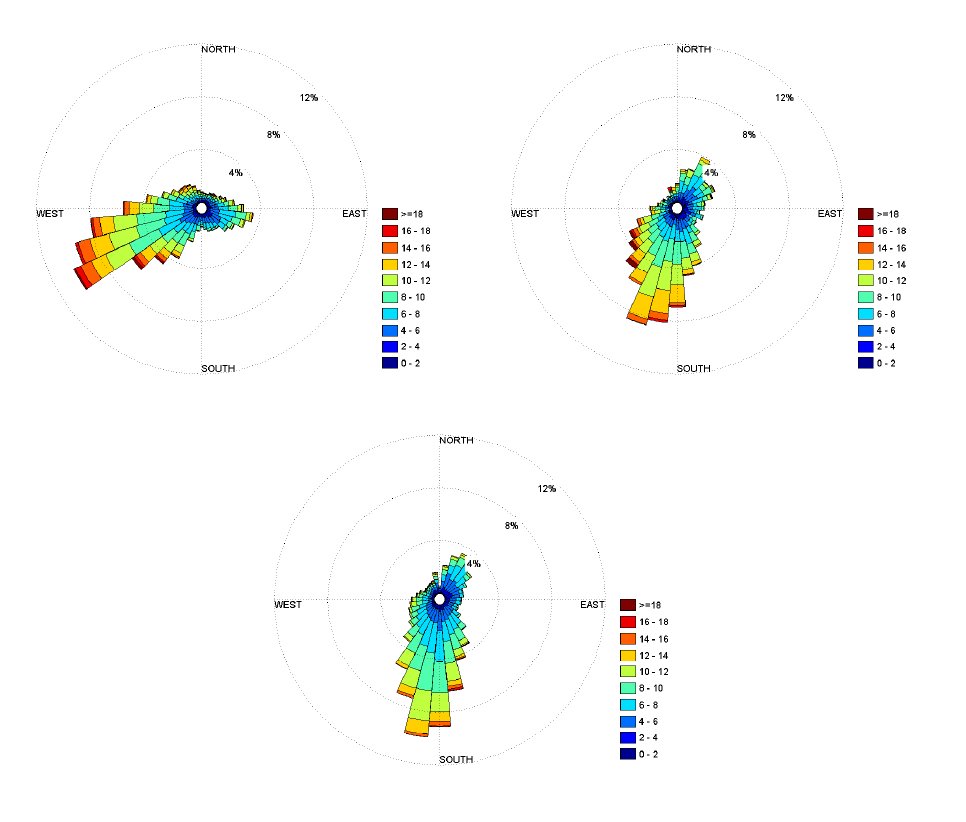
Comparison of the observed (top-left panel) and the WRF-NCAR model forecast-derived (top-right panel) wind roses at Sweetwater, TX (100 m AGL). The observed